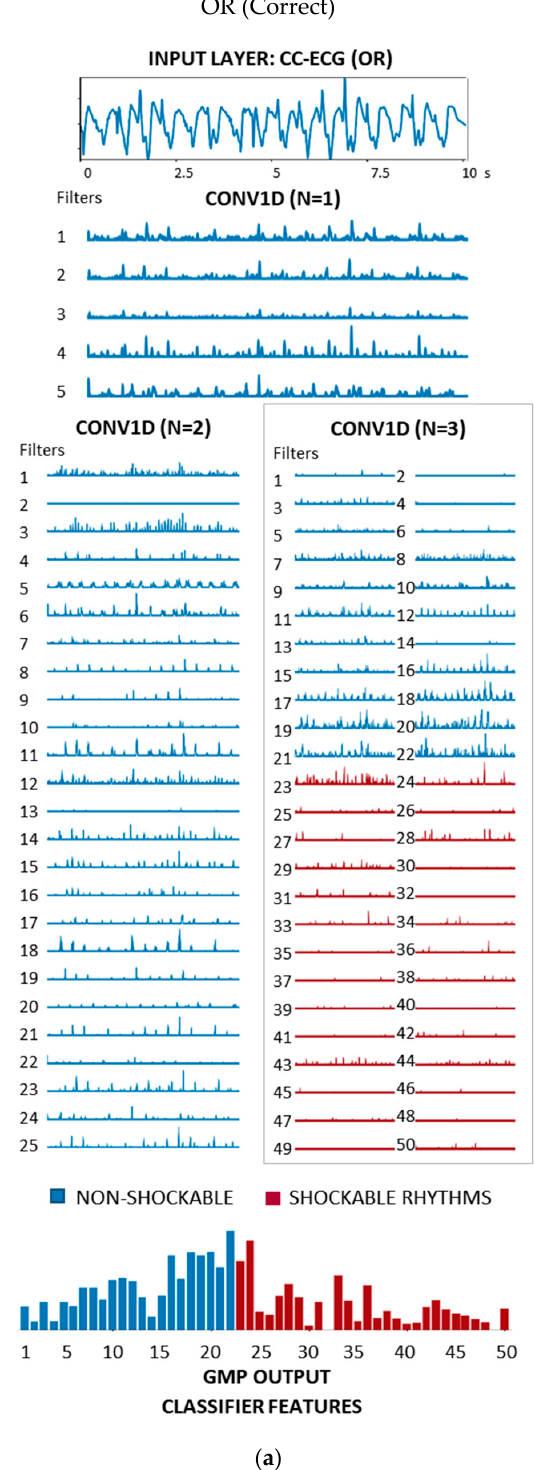
Figure 8. Features of CNN3-CC-ECG network computed for two examples of 10 s ECG-CC strips annotated as VF (Figure 1) with different shock advisory decisions: ( a ) VF (SNR = − 6.5 dB) correctly detected as Sh rhythm with output probability pSh = 0.97; ( b ) VF (SNR = − 12.9 dB) erroneously detected as NSh rhythm with output probability pSh = 0.007. The under- lined 50 filters at the output of CONV1D (N = 3) are used for computation of 50 classifier features (bottom plot), grouped for Sh (red) and NSh (blue) rhythms in accordance with the sign of the classifier weights.